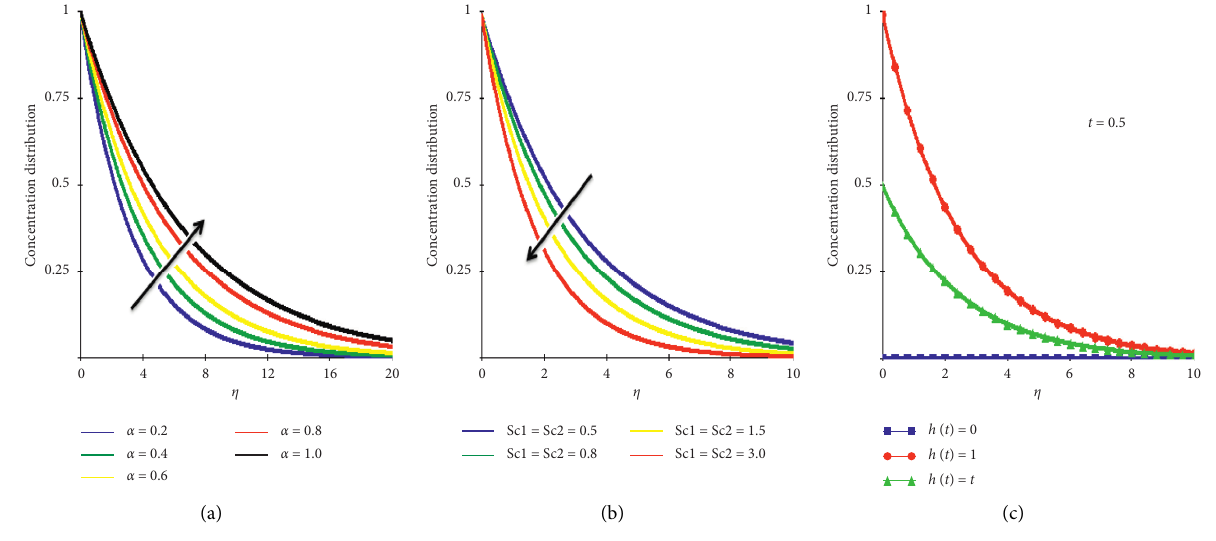
Figure 5: Sketch concentration profile for changing α , Sc, and h ( t )